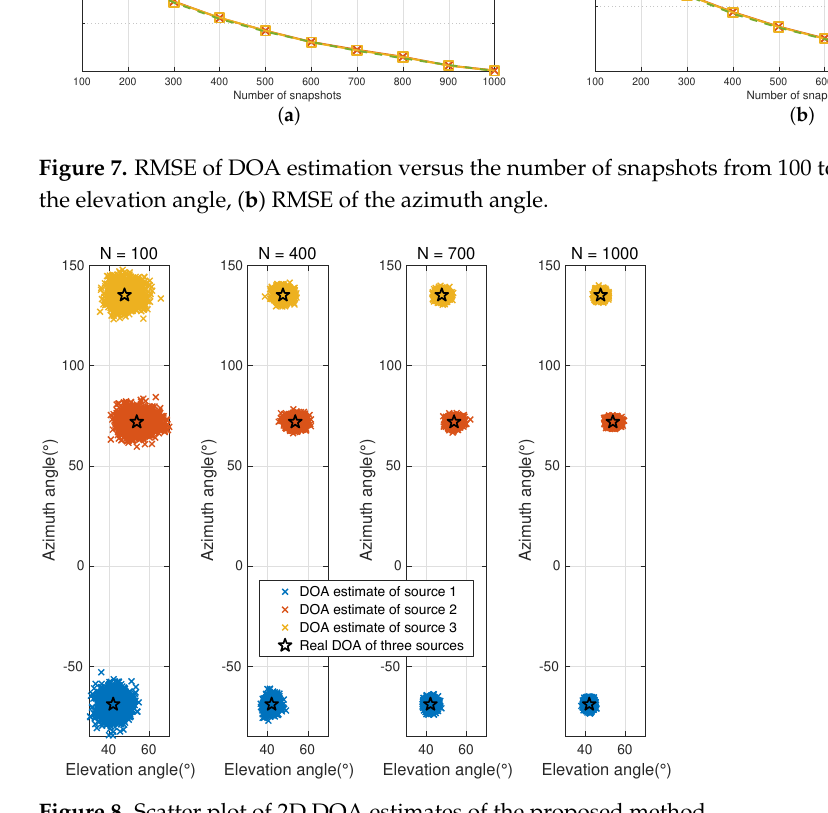
Figure 8. Scatter plot of 2D DOA estimates of the proposed